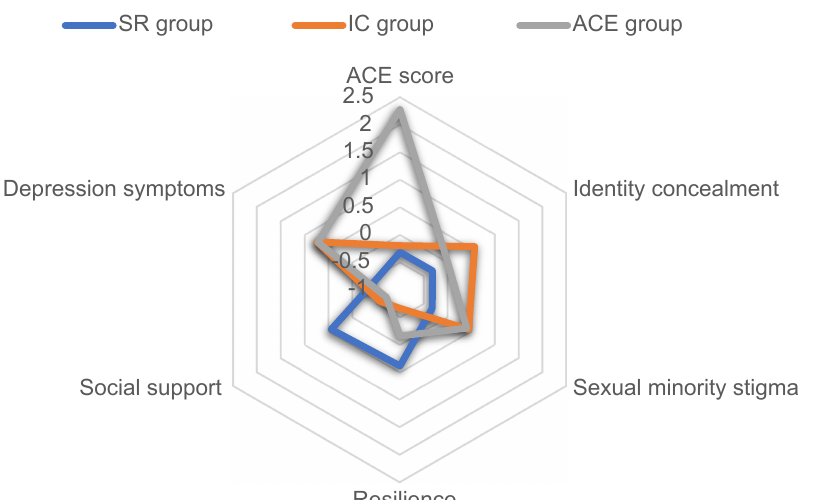
Fig. 1 Latent classes by categorical Z-score